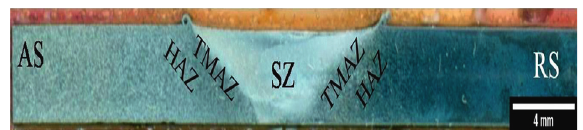
Figure 2: Microstructural welding zones of friction stir-welded aluminium alloy.